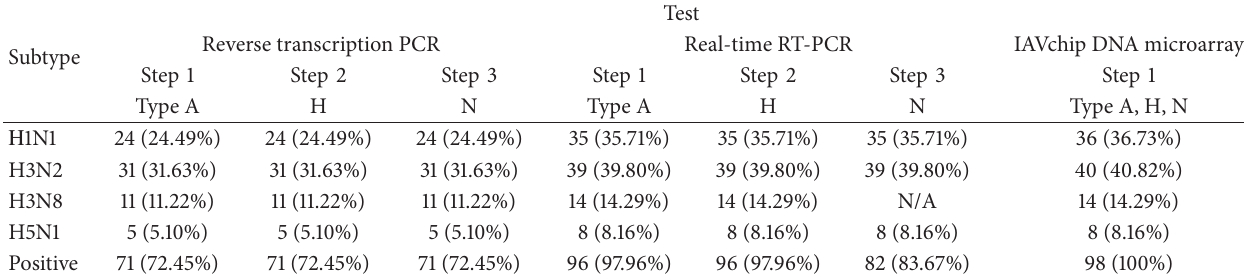
Table 6: Results of detecting influenza A virus subtypes in clinical specimens by various